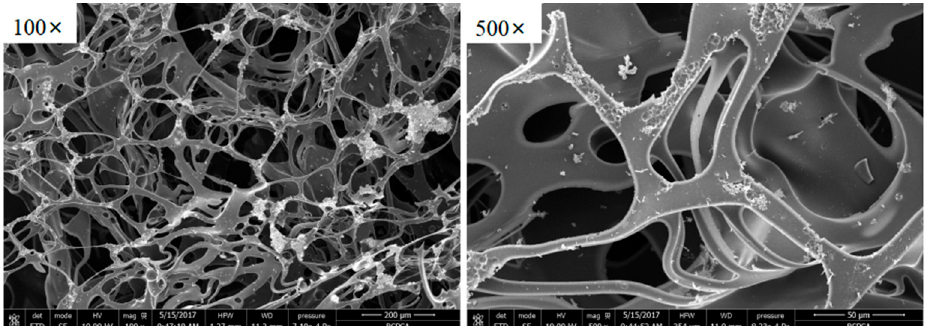
Figure 5. The SEM morphologies after cone test of 5.25%PEPE-TPU.